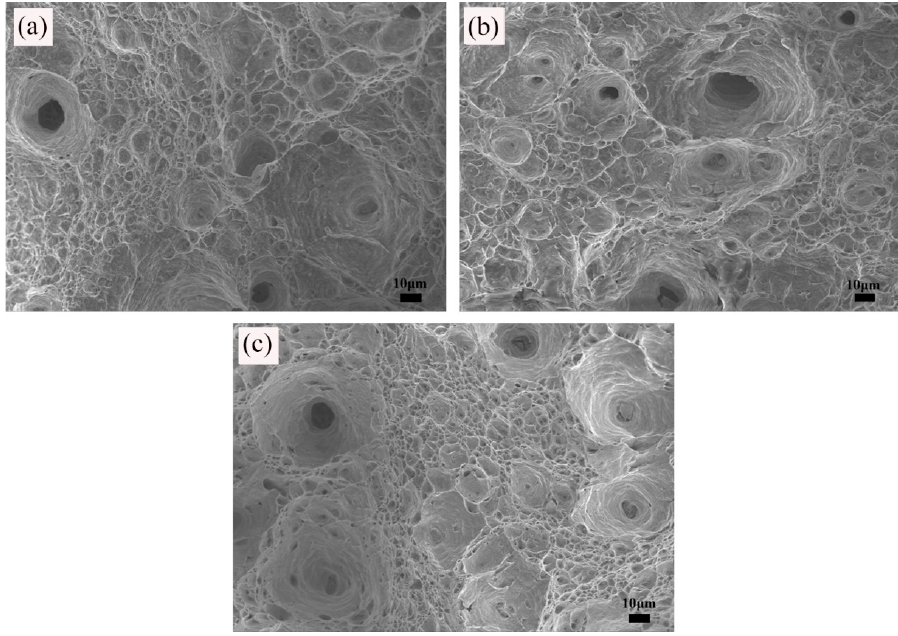
Figure 6. Fracture morphology of the creep-fractured samples for the different stress levels: ( a ) 160 MPa, ( b ) 180 MPa, and ( c ) 220 MPa. ( a ) 160 MPa, ( b ) 180 MPa, and ( c ) 220